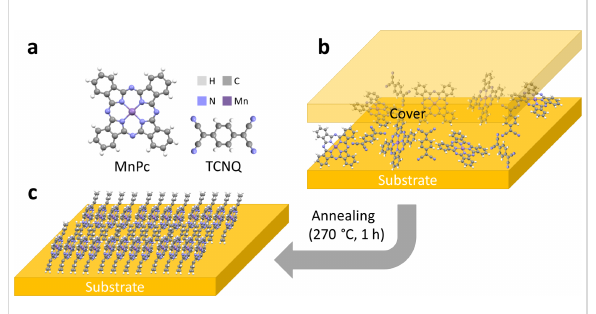
Figure 1: (a) Manganese phthalocyanine (MnPc) and tetracyanoquino- dimethane (TCNQ) molecules. (b) Annealing procedure applied to the blended thin films prepared by OMBD. (c) Well-ordered β -MnPc film after